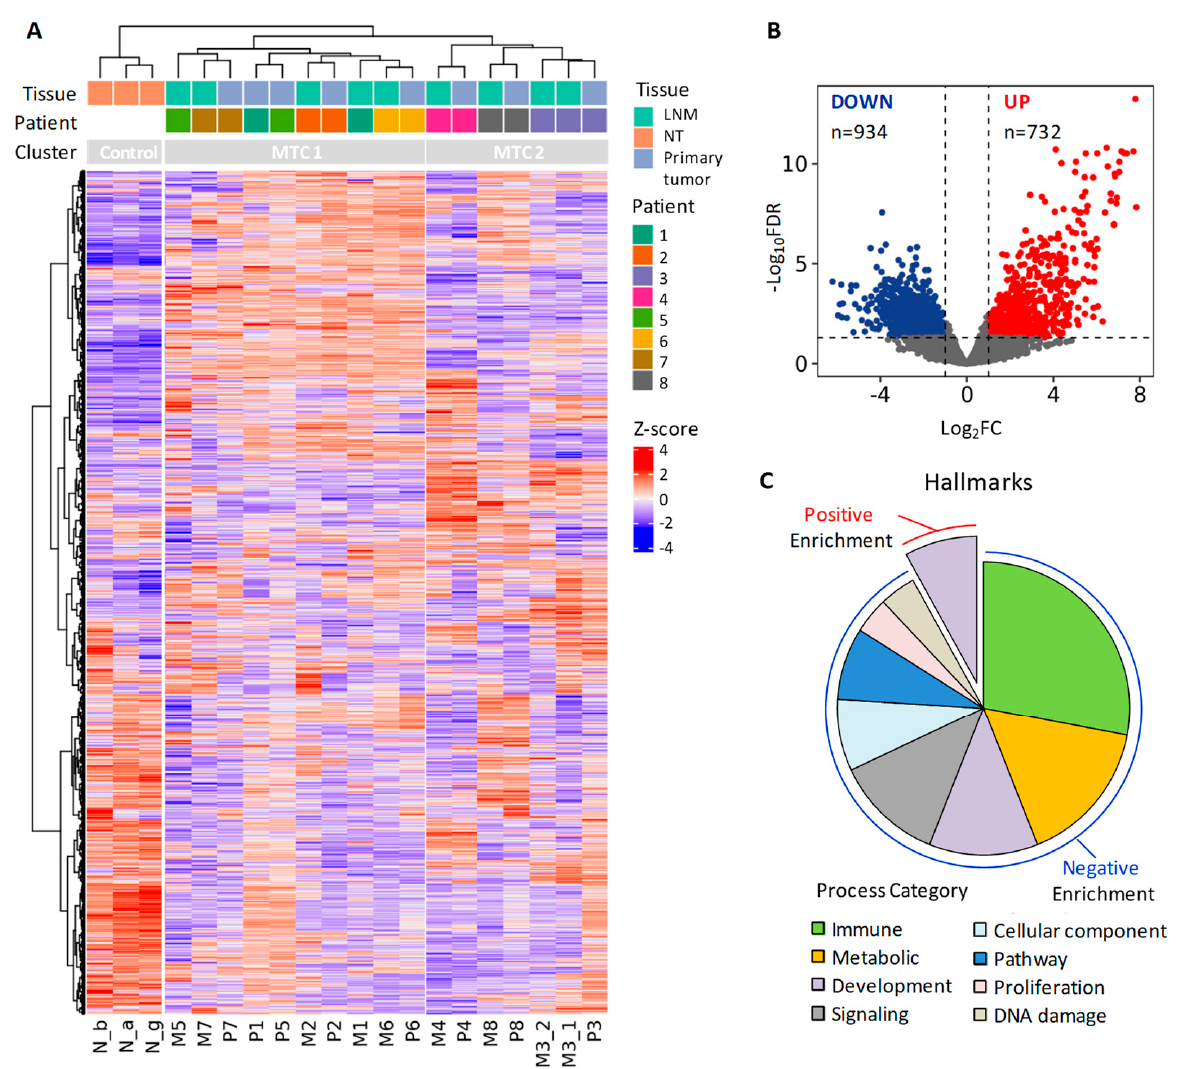
Figure 4. Gene expression profiles in our sporadic MTC cohort. ( A ) Unsupervised hierarchical clustering according to the top 2000 most variable genes in the proprietary series of 17 sporadic MTCs (patient-matched primary tumors and lymph node metastases (LNMs)) and 3 non-neoplastic thyroid (NT) controls. ( B ) Volcano plot of differentially expressed genes in MTC compared to NT. Log2 fold change (FC) and − log10 false discovery rate (FDR) values are shown; dashed lines represent cutoffs for differentially expressed gene selection (absolute FC > 2 and FDR < 0.05). Up- and downregulated genes are shown in red and in blue, respectively. ( C ) Distribution of the significant (FDR < 0.05) Hallmarks process categories from GSEA relative to the gene set shown in ( B ); see Figure S1C for Hallmarks collection complete data.